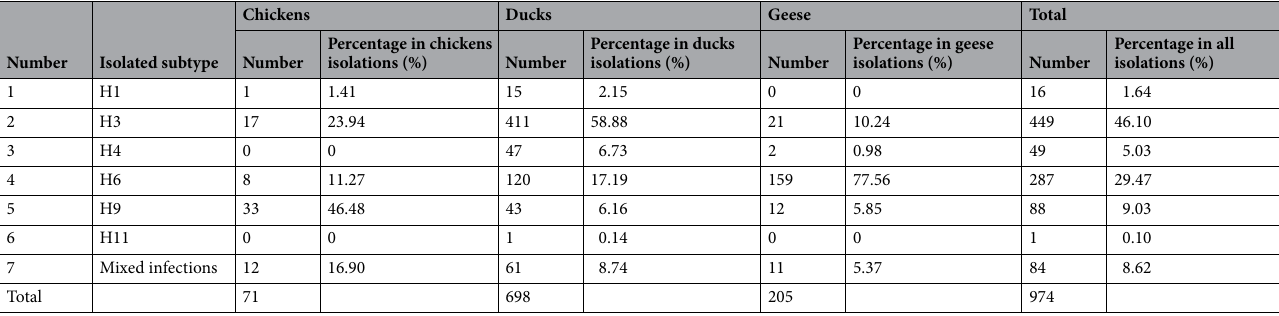
Table 1. Distributions and percentages of the isolated HA